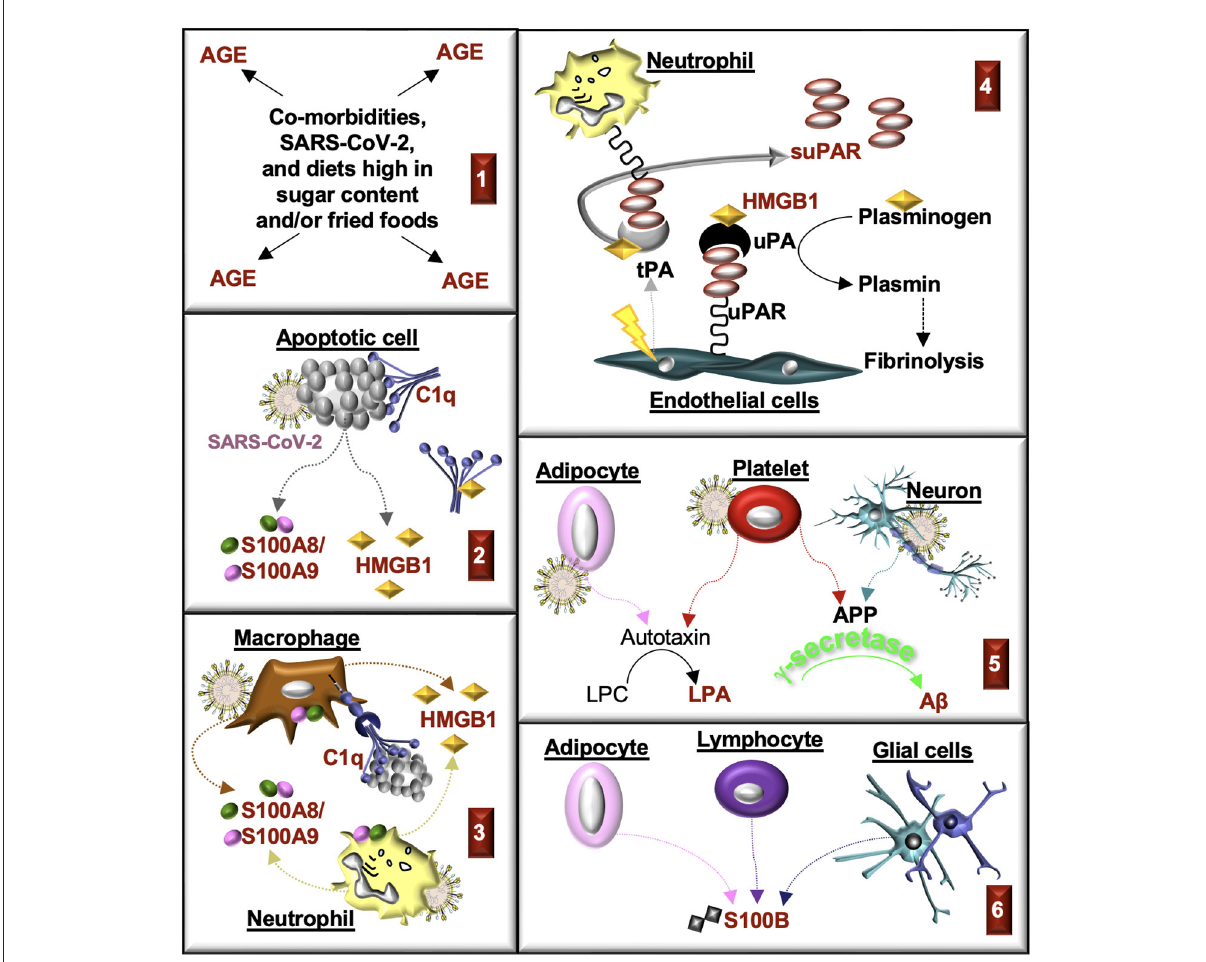
FIGURE7 Production of RAGE ligands during CKD and COVID-19 . RAGE ligands are highlighted in red. (1) Advanced glycation end-products (AGE) accumulate in comorbidities associated with CKD and COVID-19. AGE are produced in response to SARS-CoV-2. AGE are also consumed in the diet. (2) Cells damaged in response to injury or SARS-CoV-2 infection undergo apoptosis. Apoptotic cells produce S100A8/S100A9 and HMGB1 and generate antigens that bind C1q. HMGB1 can also bind with C1q and form a complex with RAGE and CD305 to induce cell signals that form resolvins and an M2 macrophage phenotype. (3) C1q promotes macrophage phagocytosis of apoptotic cells, in part, through binding to RAGE. Myeloid cells release S100A8/S100A9 and HMGB1 in response to injury and infection. (4) plasminogen activators (PA; tissue, tPA; urokinase, uPA) are commonly released from endothelial cells in response to injury (tPA) or growth factors (uPA). HMGB1 binds tPA, uPA, and plasminogen, which enhances the rate of plasminogen activation, the formation of plasmin, and fibrinolysis. Urokinase-type plasminogen activator receptor (uPAR) on immune cells, fibroblasts or endothelial cells is cleaved by proteases (e.g., uPA, tPA), which forms soluble uPAR (suPAR). (5) Activated platelets and neurons produce amyloid precursor protein (APP), which is cleaved by secretases ( β , γ ) to form amyloid- β (A β ) peptides. A β is cleared from plasma by the kidney. Activated adipocytes and platelets produce autotoxin, which transforms lysophosphatidylcholine (LPC) into lysophosphatidic acid (LPA). (6) S100B accumulates in end-stage kidney disease and severe COVID-19. The source of S100B is not known but might include lymphocytes, glial cells, and/or